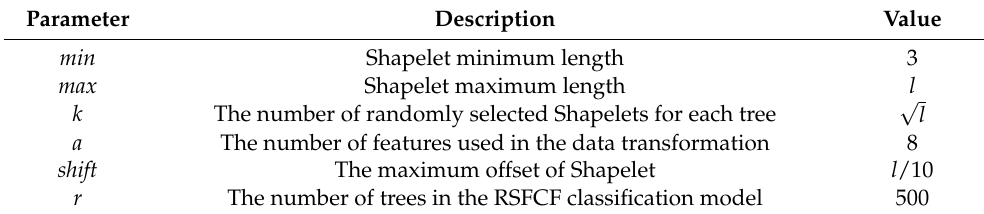
Table 1. Parameter setting of RSFCF.